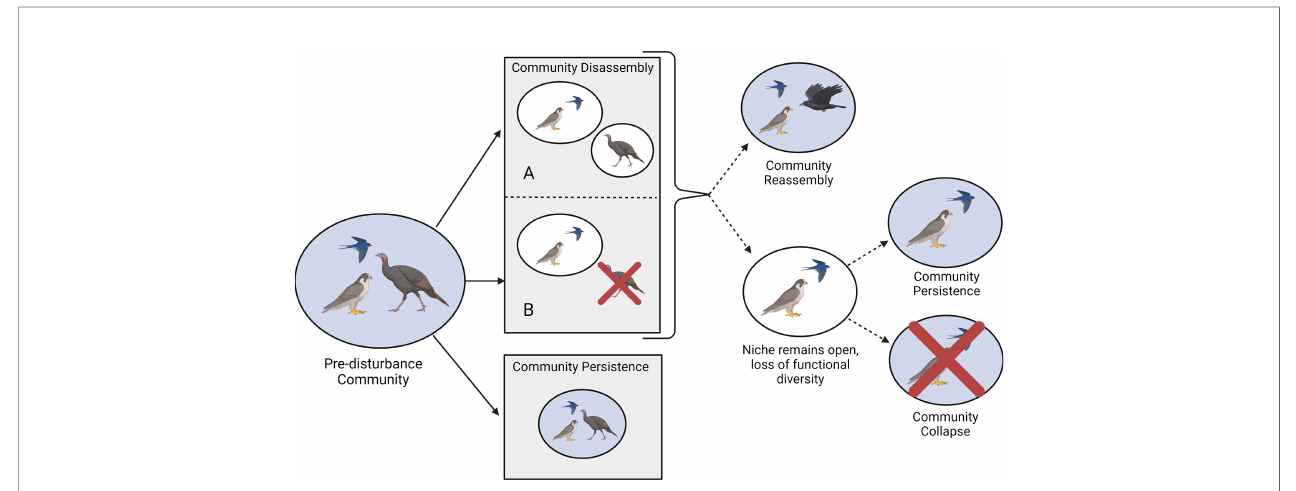
FIGURE 4 | Community shifts as a result of chronic disturbances such as climate change and urbanization. Here, distinct communities are represented by circles, where blue circles represent stable community states and white circles represent transitional community states. Arrows represent temporal progression, where the leftmost set of solid arrows coincides with the initial response to a chronic disturbance event and dotted arrows represent transitional shifts. Under community disassembly, state A represents geographic shifts by some community members and adaptation/plasticity by others, while state B represents adaptation/plasticity or geographic shifts by some community members and partial extinction of others. Alternatively, communities that exhibit adaptation, plasticity, or geographic shifts of all community members may persist, unchanged; these communities would exhibit high resistance. Communities that exhibit later reassembly or persistence following a loss of diversity would exhibit high recovery (Created with BioRender.com).